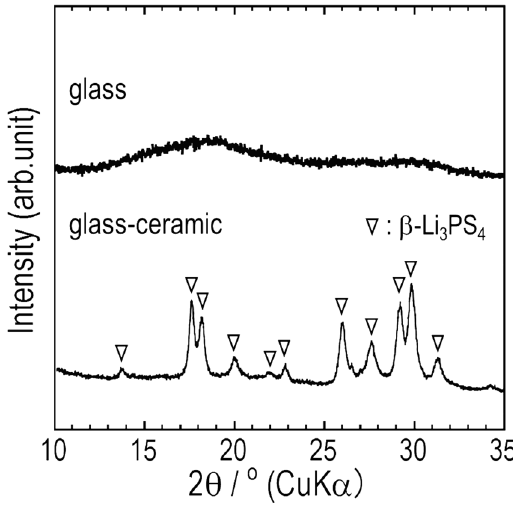
Figure 2. The XRD patterns of the 75Li 2 S·25P 2 S 5 glass and glass